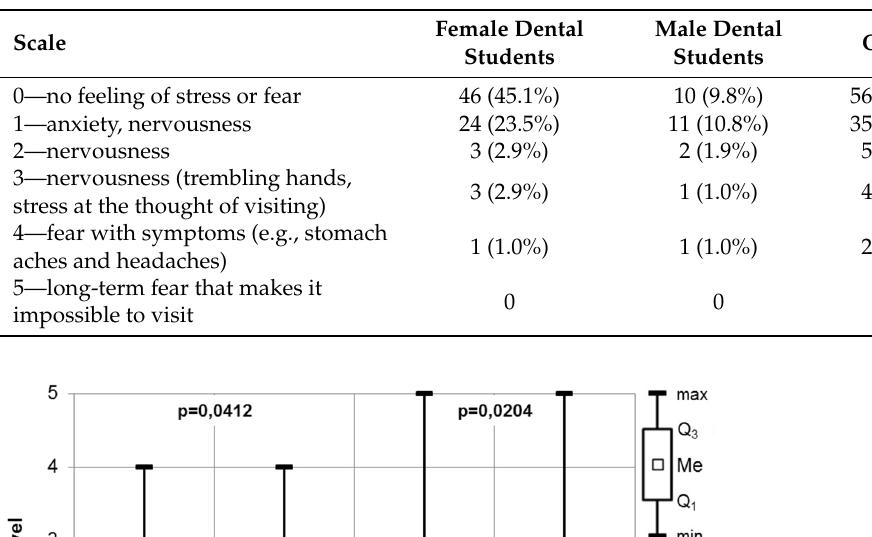
Table 8. Assessment of anxiety before visiting dentist among dental students.